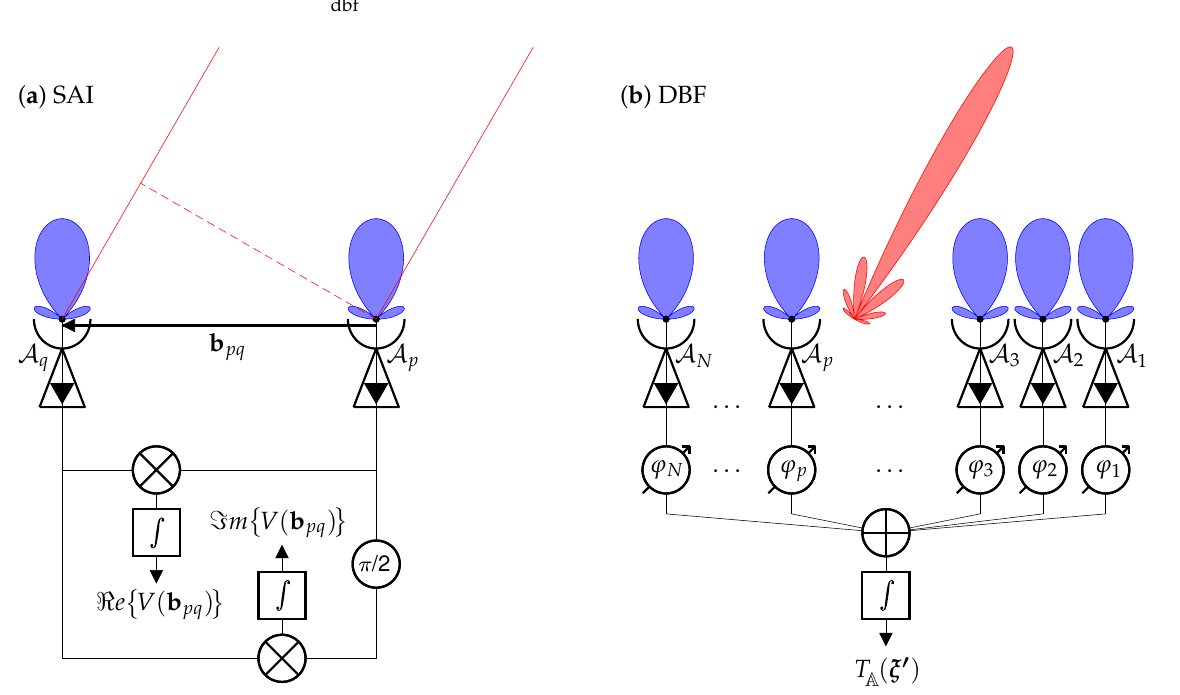
Figure 1. Illustration of the principle of the two paradigms. In both cases, all the elementary antennas are pointing in the same direction, depicted here by the main beam of the elementary power patterns (in blue). To make the illustration simpler without losing anything of the comparison, amplifiers, local oscillators, and band-pass filters are omitted. ( a ) In SAI, for every pair of elementary antennas A p and A q , the radio signals are transmitted to a complex correlation unit to be combined in-phase/in-quadrature and integrated in order to provide the real and imaginary parts of the complex visibility sample V for the baseline vector b pq . Referring to the integral in (1), the contribution from direction ξ (in red) to V ( b pq ) depends on the delay between the time a wave train (dashed red) arrives on antenna A p and its arrival on antenna A q . ( b ) In DBF, a phase control ϕ p ( ξ (cid:48) ) is applied to the radio signals so that the beam of the antenna array A is steered to the direction ξ (cid:48) , here illustrated by the main beam of the array power pattern (in red). The signals thus obtained are combined all together and integrated to provide the antenna temperature T A ( ξ (cid:48) ) from this pointing direction. Although the elementary power patterns have a wide beam, the phased combination leads to an array power pattern with a much narrower beam so that, when referring to the integral in (4), the directions ξ bringing the most important contributions to T A ( ξ (cid:48) ) are those around ξ (cid:48) . When the phase control is applied by computational mean, several beams can be simultaneously steered in various directions, provided the processing capacity is appropriate to apply the different sets of phase shifts corresponding to every